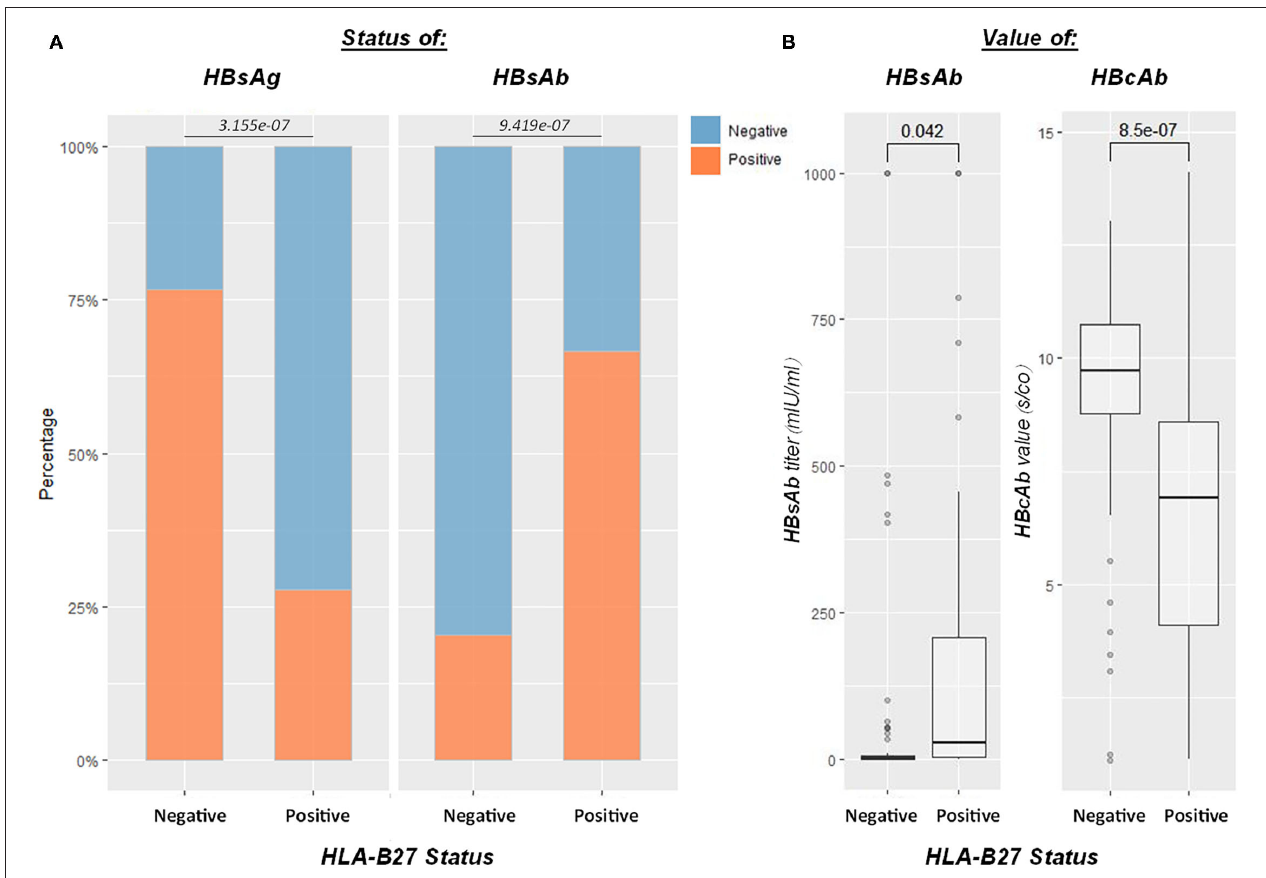
FIGURE 5 | Influence of HLA-B27 positivity on the HBV infection outcome. Efficient HBV control in HLA-B27-positive patients ( n = 118 for HBcAb-positive patients who underwent HLA-B27 screen). (A) From left to right, plots showed HBsAg, HBsAb status between HLA-B27 positive and negative patients, respectively; (B) the last two boxplots demonstrated HBsAb and HBcAb levels between HLA-B27 negative and positive patients. HLA-B27 positive patients had significantly higher HBsAb and lower HBcAb than negative